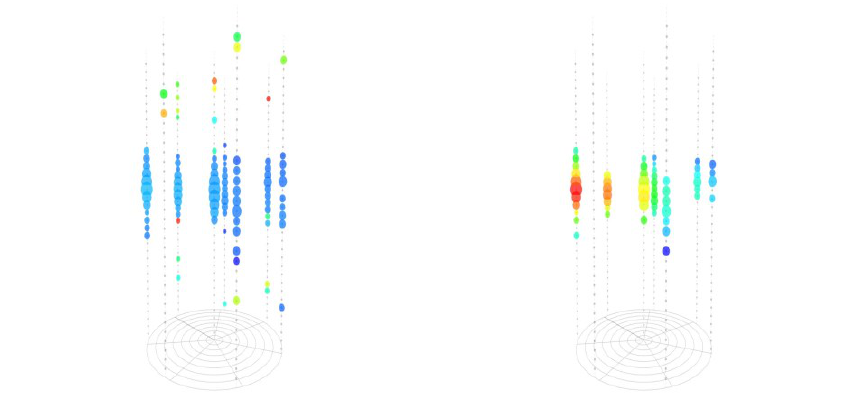
Fig. 1. Left: Multiplicity distribution of hit OMs for experimental events with reconstructed energy Fig. 3. The event with multiplicity 38 was observed on April 2016 . The left plot shows all hits; E rec > 100 TeV (dots). Also shown are the distributions of expected events from astrophysical the right plots shows the hits, which survived all cuts. Note that the color scale that indicates the neutrinos with an E -2.46 spectrum and of background events from atmospheric muons and neutrinos. relative times is Right: The event with a hit multiplicity of 17 was observed on October 2015.